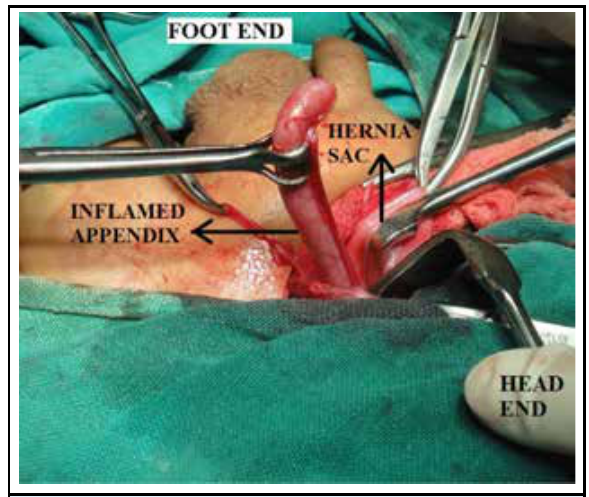
Figure 1. Left sided irreducible inguino-scortal swelling.